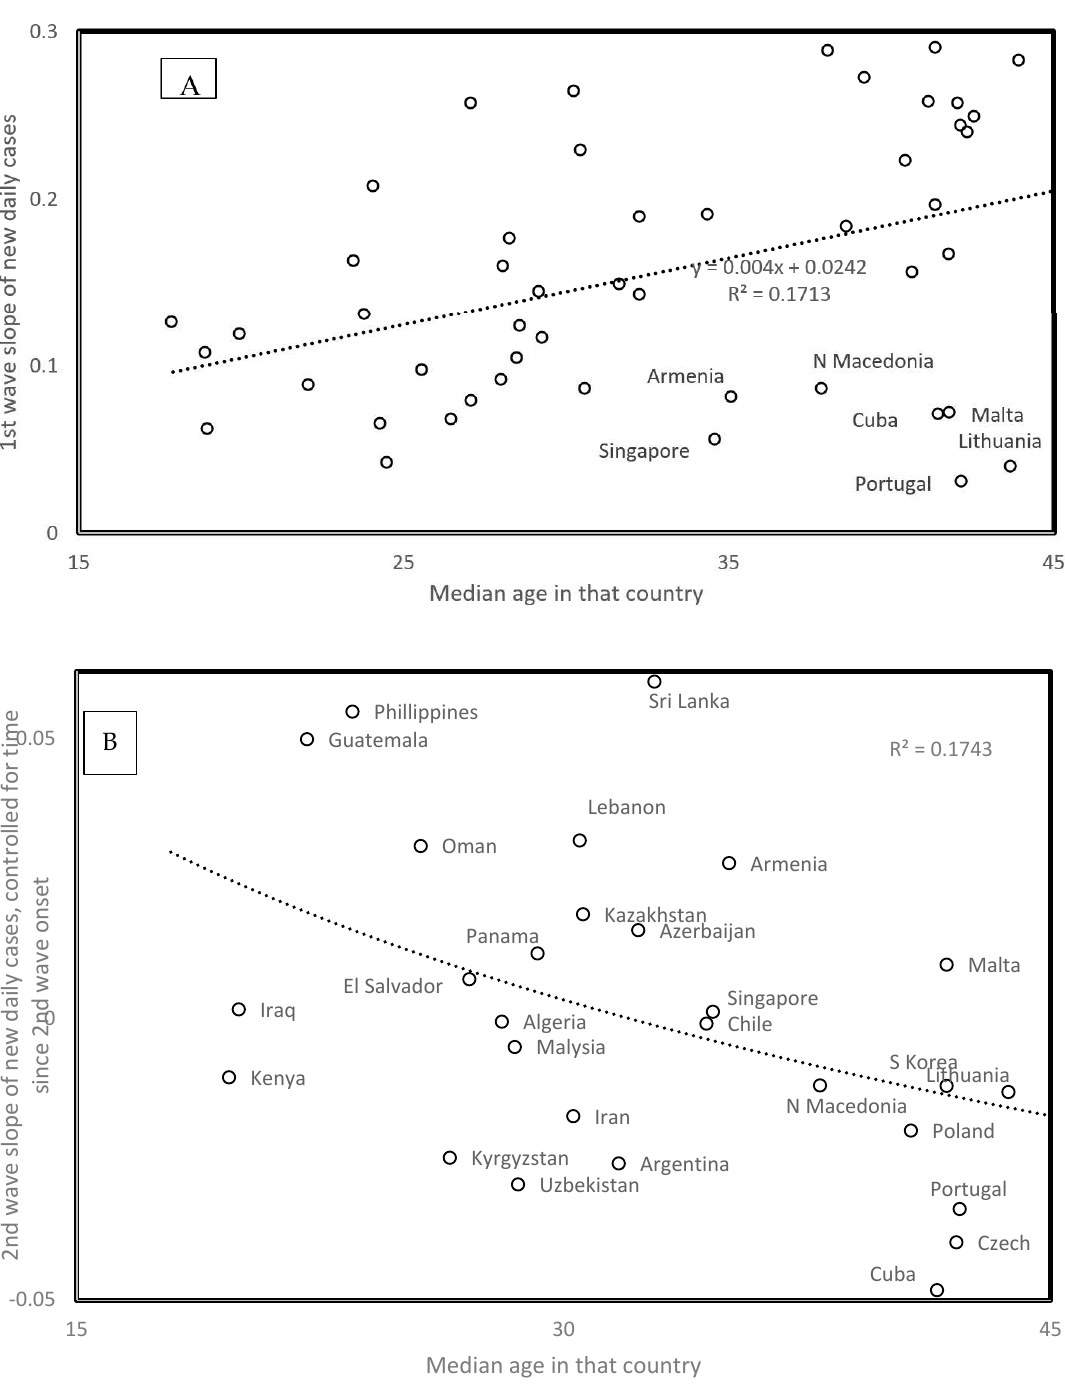
Figure 6. ( A) First wave slope and ( B ) second wave slope, as a function of country median age. For second wave slopes, the figure plots the residual values after adjusting second wave slopes for time since second wave start (regression in Figure 4B), which corresponds to the main correlate of second wave slopes. Data are from Table 1.